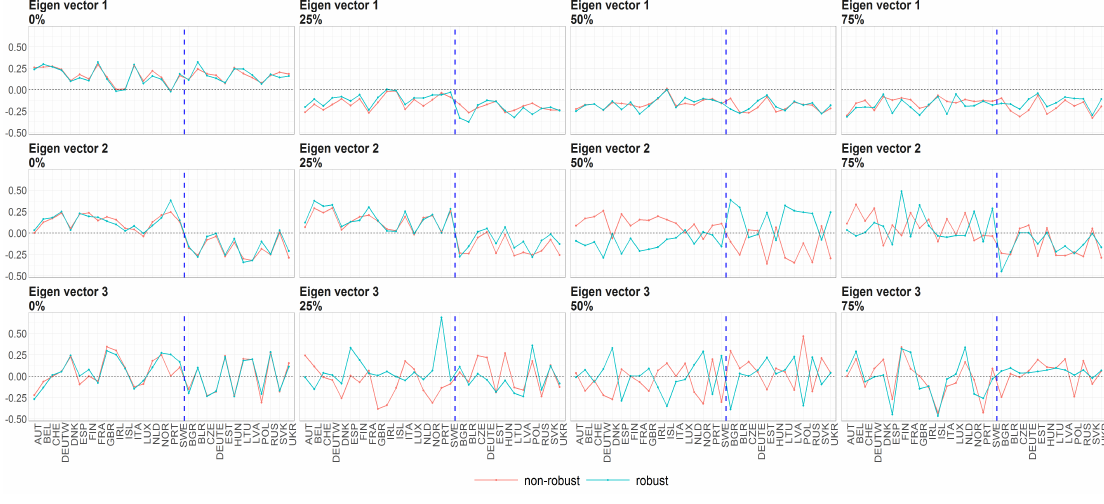
Figure 13. The eigenvectors (y axis) over the joint distribution of countries (x axis) obtained using PPCA for female population of Life Expectancy at Birth. Every row of subfigure corresponds to different eigenvector. Every column corresponds to different level of maximum missing values per observation (0%, 25%, 50% and 75%). The blue line corresponds to robust standardisation whereas red line to non-robust standardisation of data.